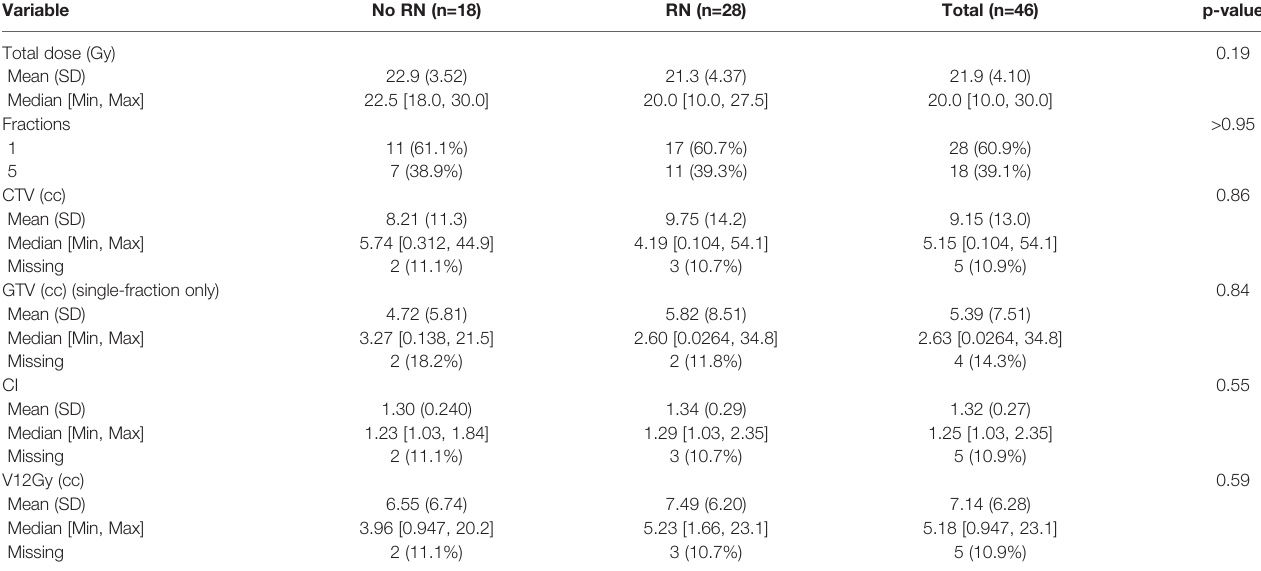
TABLE 2 | Radiation